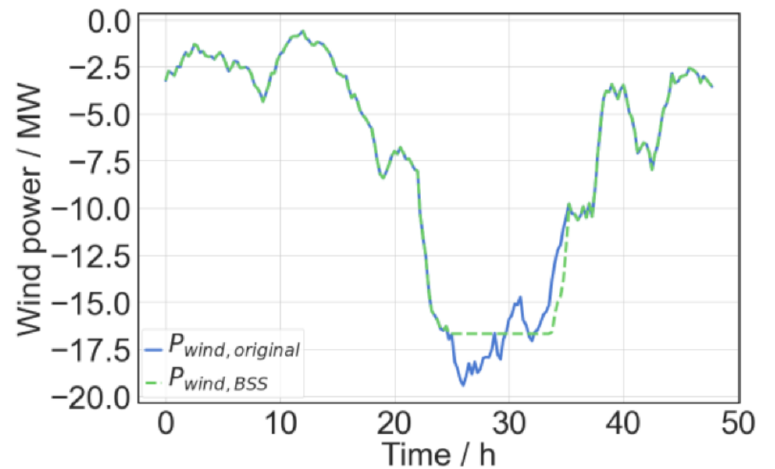
Figure 14. Injection power of the wind plants initially (blue trace) and after application of the BSS (green trace).